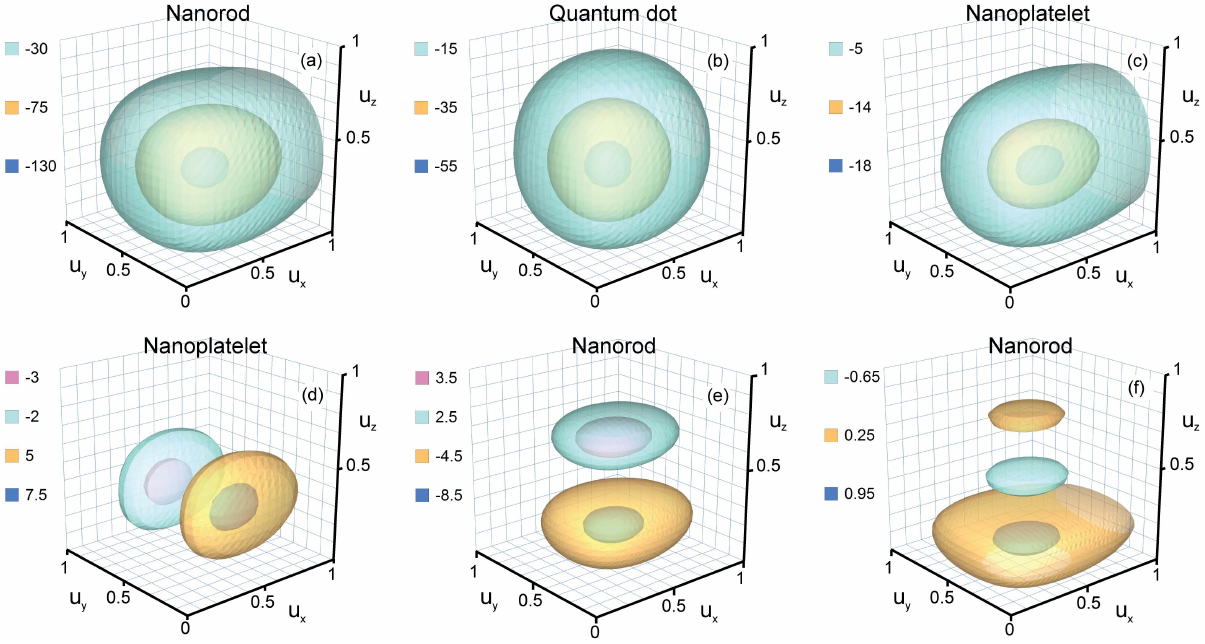
Figure 2: Isosurfaces of rotatory strength R ba (in the units of 10 −39 erg × cm 3 ) in the first octant of 2 × 3 × 9 nm 3 nanorod, 3.4 × 3.8 × 4.2 nm 3 quantum dot, and 1.5 × 5 × 6 nm 3 nanoplatelet. Transitions occur from the ground state (111) to state (121) in panels (a)–(c) and to states (141), (124), and (116) in panels (d), (e), and (f), respectively. All the plots are in normalized coordinates u v = 2 v / l v ( v = x , y , z ) . The modeling material is InP and the simulation parameters are: ε 0 = 12.35 , ε = 9.61 , m * = 0.08 m 0 ( m 0 is the free-electron mass), and r B = 8.12